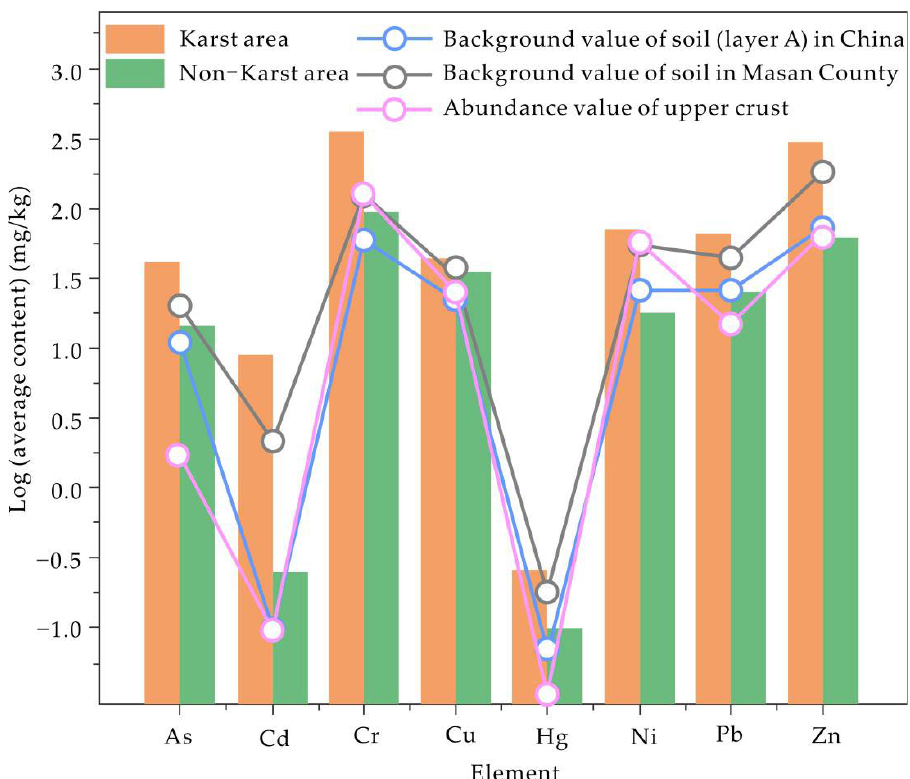
Figure 2. Comparison of soil heavy metal content between karst and non-karst